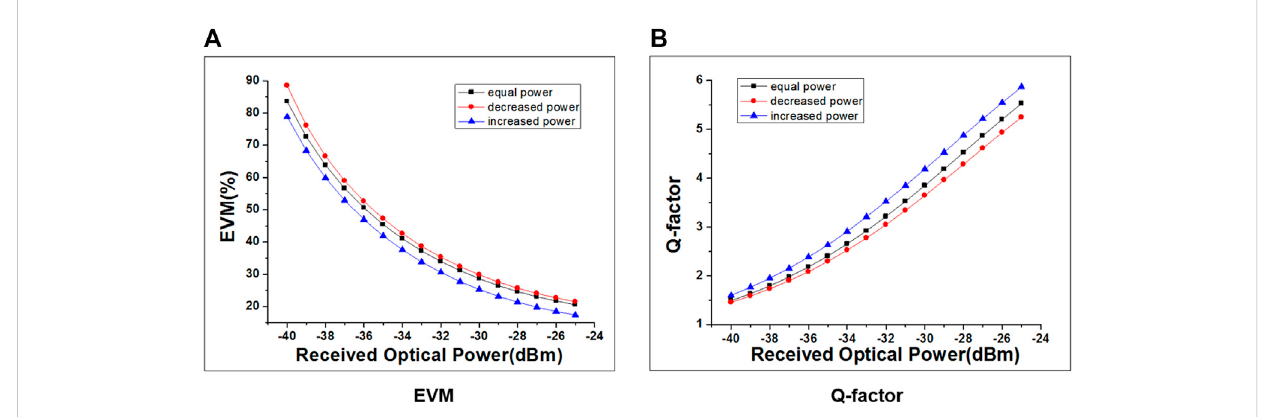
FIGURE 9 EVM and Q-factor curves under different pilot power schemes. (A) EVM curves; (B) Q-factor